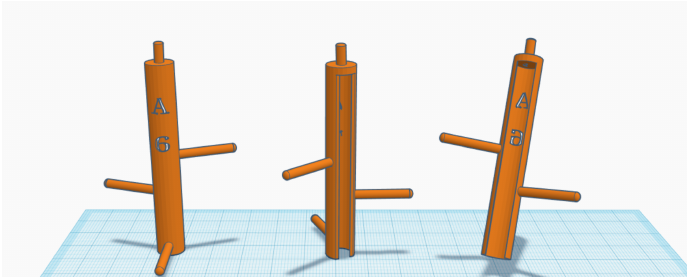
Figure 7. Marker tool design. The marker tools have been designed to be as light as possible, easily attachable/detachable, and easily